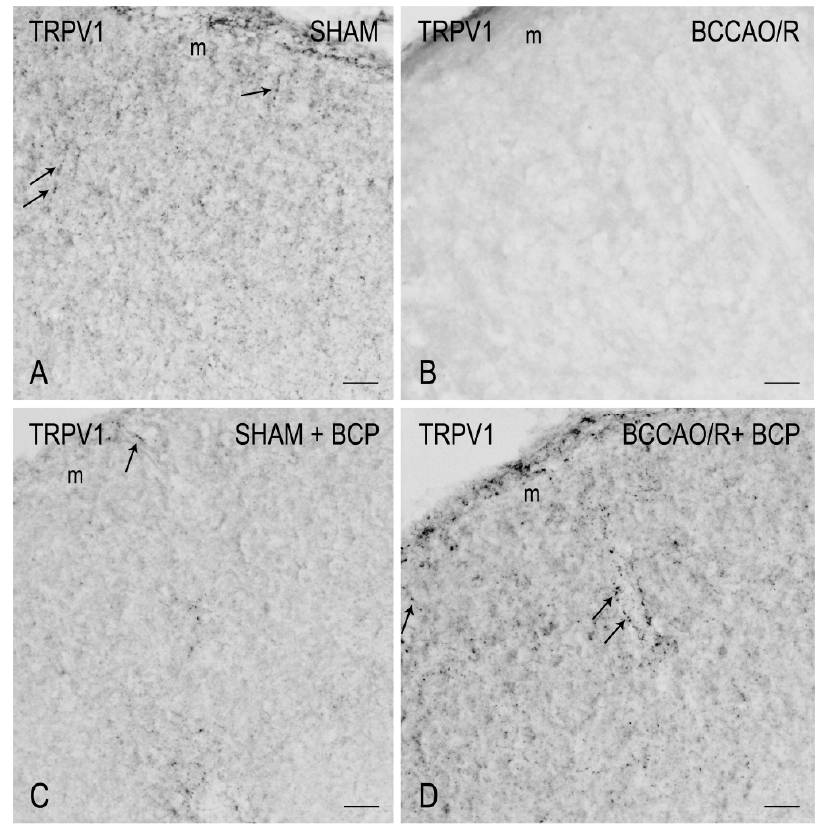
Figure 3. Transient receptor potential vanilloid type-1 receptor (TRPV1)-like immunoreactivity in coronal sections of frontal cortex of sham-operated and bilateral common carotid artery occlusion followed by reperfusion (BCCAO/R) rats, pre-treated with either the vehicle alone ( A , C ) or with beta-caryophyllene (BCP) ( B , D ). TRPV1-immunoreactive neural processes and punctate elements are distributed across the whole thickness of the cortex, often associated with blood vessels (arrows). Panels are representative of observations carried out in 6 rats for each group. m, molecular layer. Scale bars: 25 μ m .